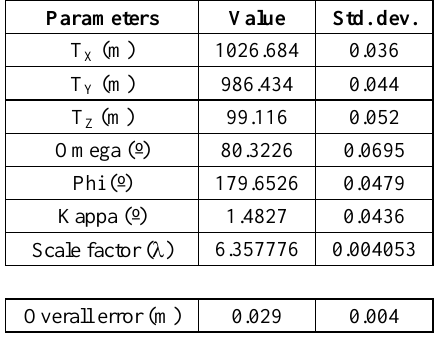
Table 6. Helmert 3D transformation parameters between UAV and